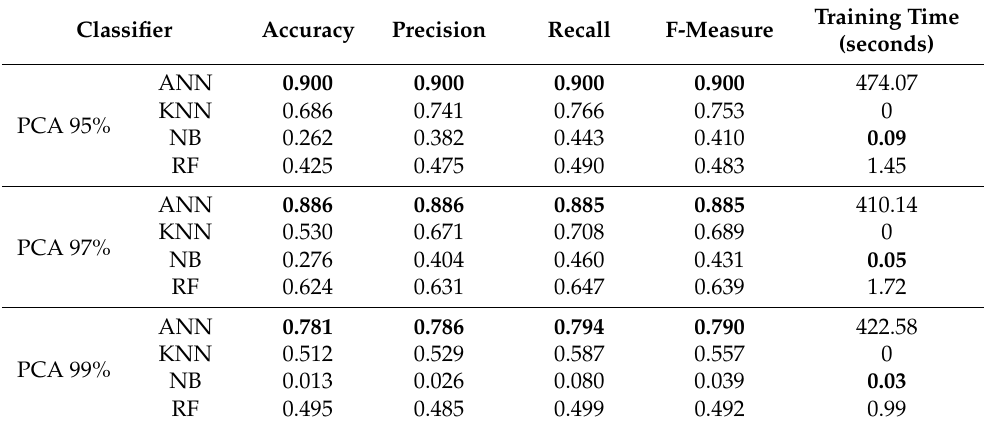
Table 5. Identification results of VGG-19-F6 deep features with PCA (95%, 97%, and 99%). Bold values signify the best performance.